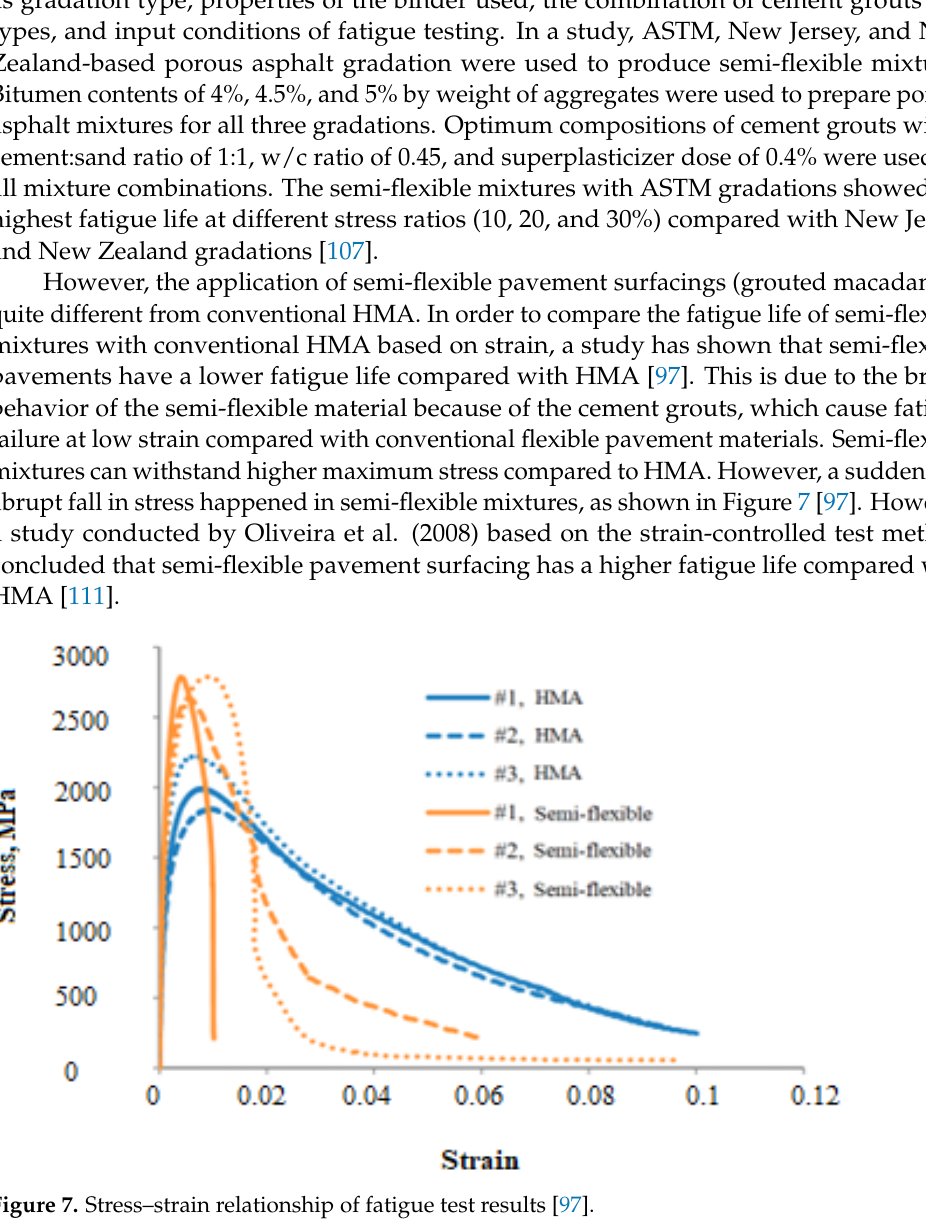
Figure 7. Stress–strain relationship of fatigue test results